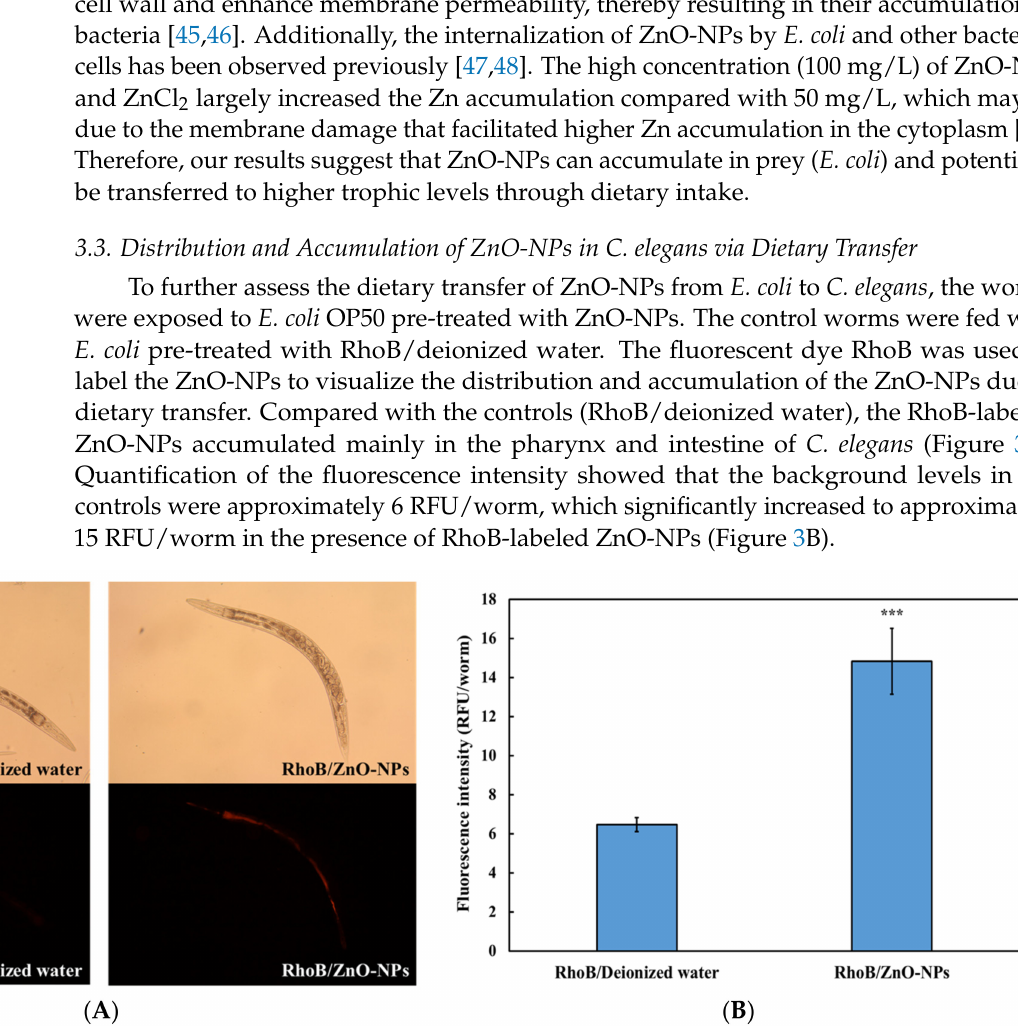
Figure 3. Accumulated ZnO-NPs in C. elegans through dietary transfer. Wild-type N2 C. elegans L1-larvae were fed with rhodamine B (RhOB)-labeling ZnO-NPs (RhoB/ZnO-NPs) pretreated E. coli OP50 for 96 h. RhoB/Deionized water was used as the control. After exposure and washing, ( A ) fluorescence images of worms were taken, and ( B ) fluorescence intensity was analyzed using ImageJ. The data are shown as the mean ± SEM. The tests were conducted at least three times independently, and 25 worms were scored per treatment in each replicate. Statistical significance was determined by ANOVA with LSD post-hoc test to compare to the control. (***: p <